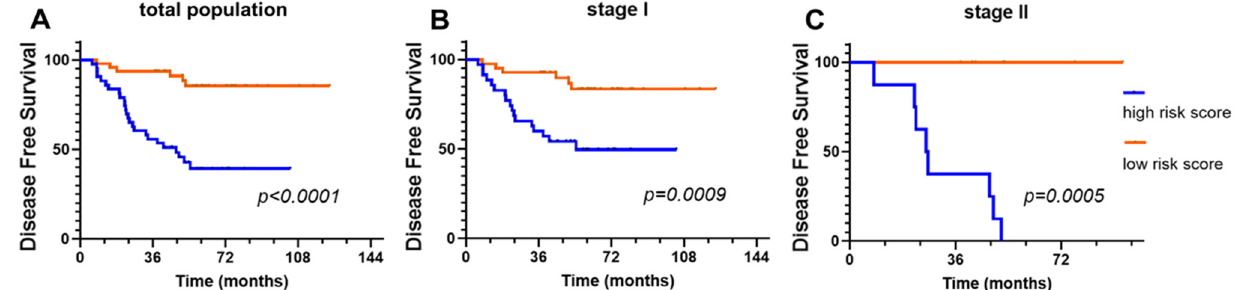
Figure 5. Kaplan–Meier curves according to the predicted risk of recurrence for lung adenocarcinoma patients. The survival of patients with a high-risk score (blue) vs. low-risk score (red) was compared in the total population ( A ), as well as in the stage I ( B ) and stage II ( C ) subgroups in cohort II (external validation set). Table 5. Risk factors for the 3-year recurrence of patients with surgically resected lung adenocarci- noma in the external validation sets ( n = 91).